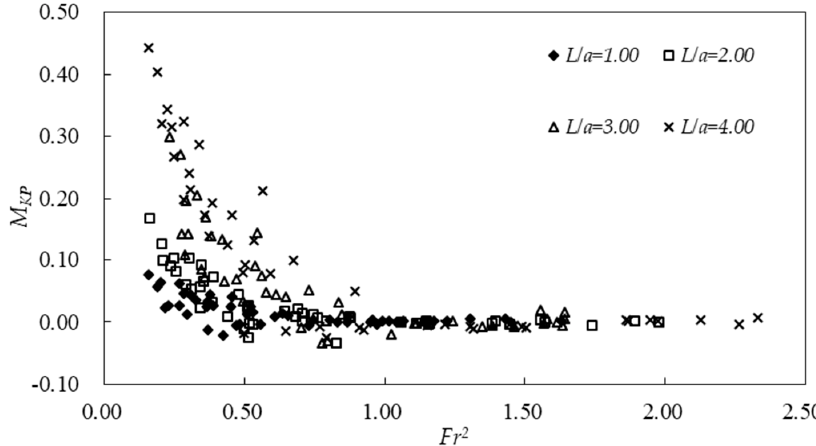
Figure 7. M KP vs. Fr 2 for L/a = 1.00, 2.00, 3.00 and 4.00.